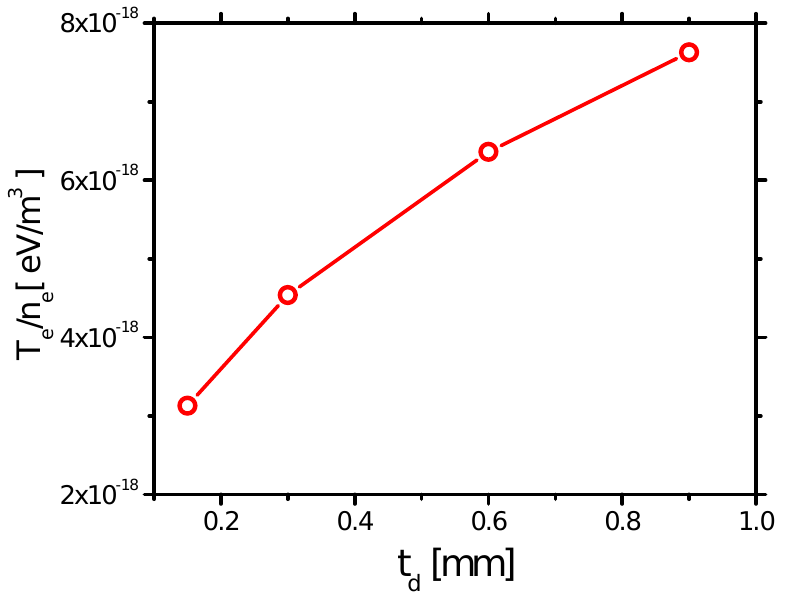
Figure 27. The effects of t d on the average electron temperature per unit electron density T e and Cases